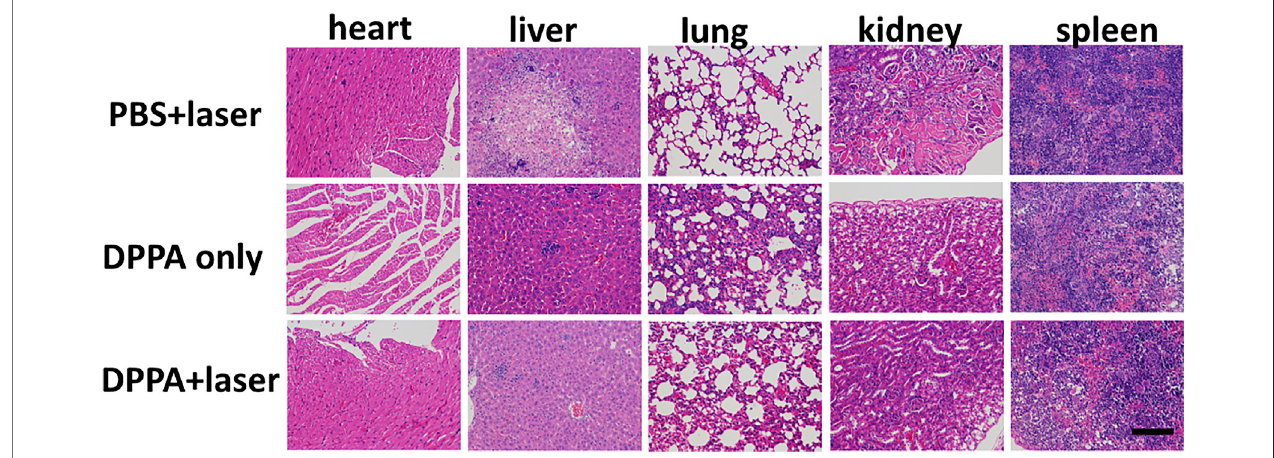
FIGURE 6 | H&E pictures of the heart, liver, lungs, kidney, and spleen in the PBS + laser, DPPA-only, and DPPA + laser groups. Scale bar: 10 μ